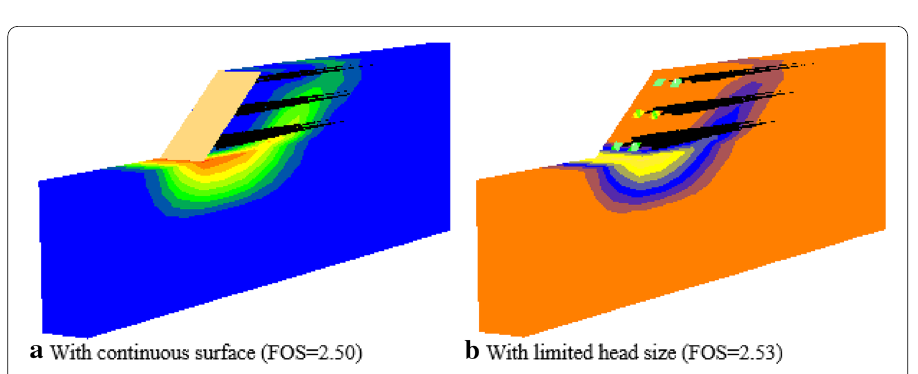
Fig. 12 Effect of nail head size on the nailed embankment slope